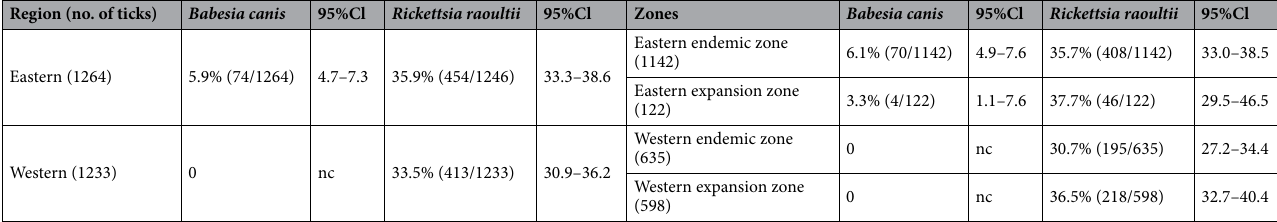
Table 1. Prevalence of B. canis and R. raoultii in D. reticulatus ticks in four zones. Nc not